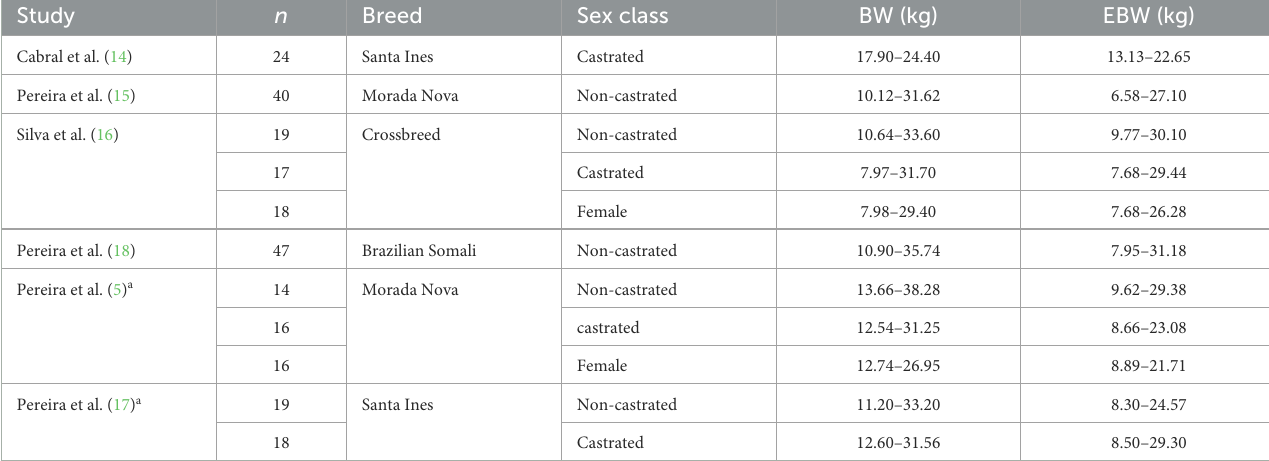
TABLE 1 Summary of studies used to estimation of net mineral requirements for the maintenance and gain of hair sheep.